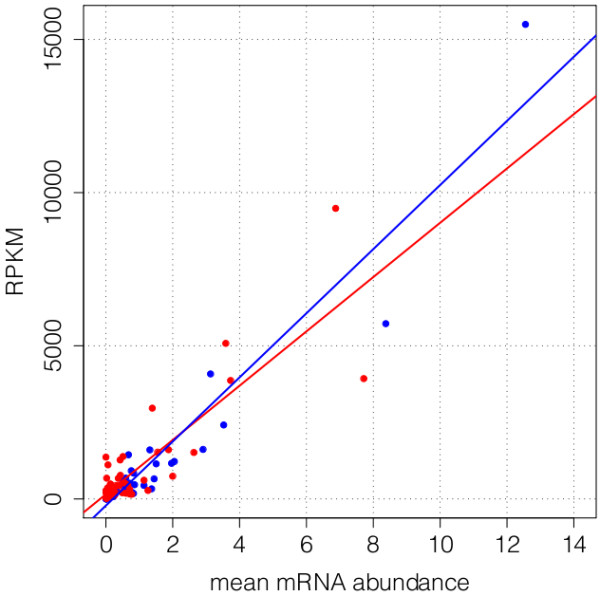
RPKM values (454 sequence data) versus mean qPCR mRNA abundance for NDI and DI treatments. NDI treatments are shown in red, DI in blue. Lines from the linear regressions for each photoperiod treatment, after removal of the outlier histone2A, are plotted as solid lines (r2(NDI)= 0.70; r2(DI)= 0.90).